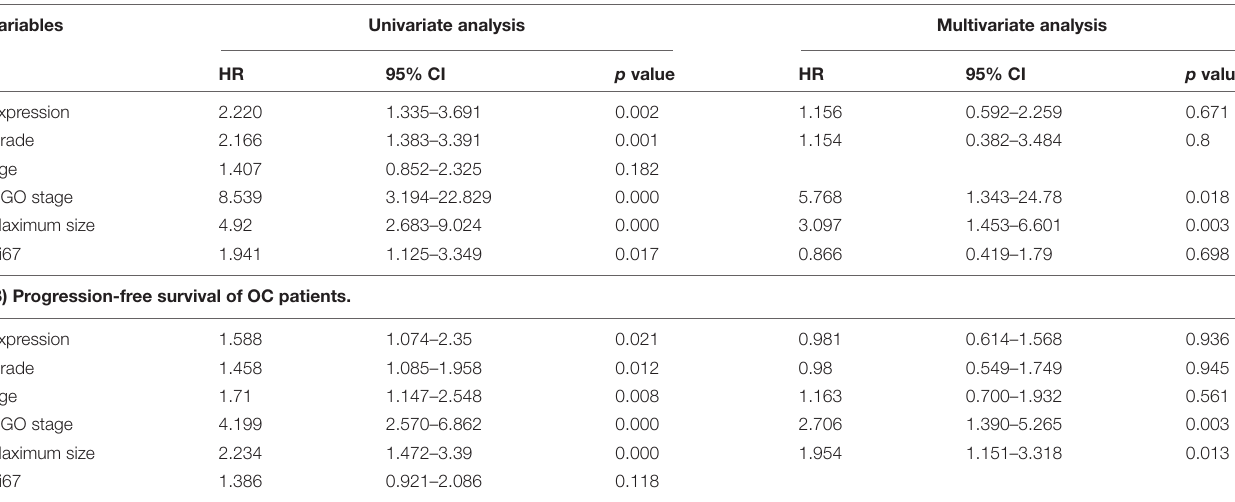
TABLE 2 | Univariate and multivariate analysis of the factors correlated with (A) overall survival Variables